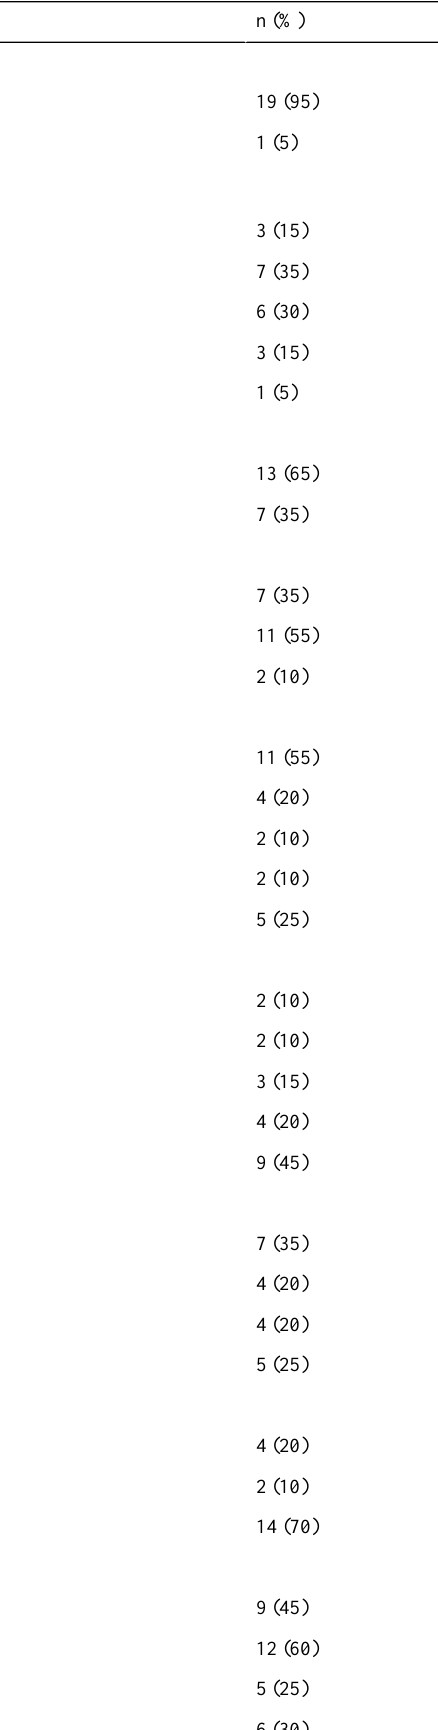
Table 1. Sample characteristics of participants in SLIDES